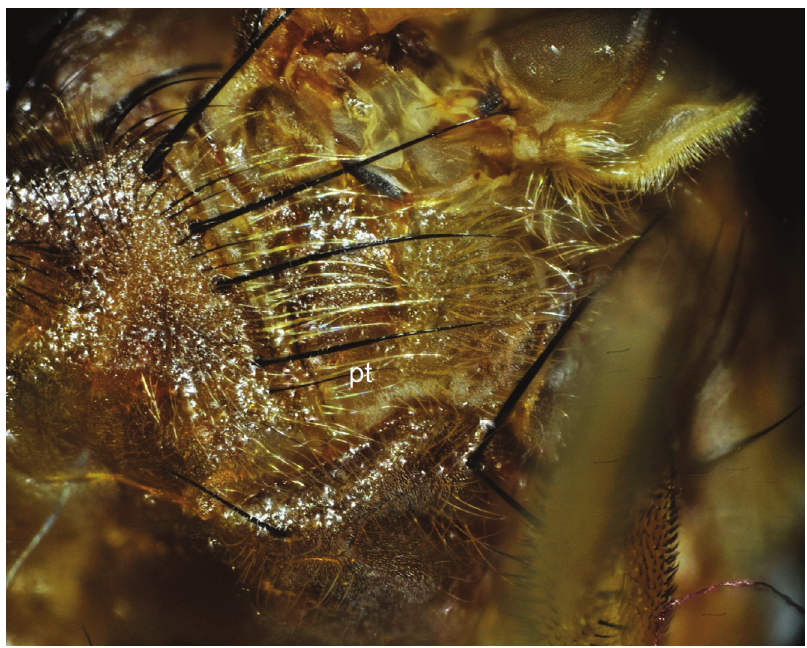
Figure 1. Pteropleuron (pt) of Bengalia torosa (Wiedemann), hairs on pteropleuron are wholly yellowish.